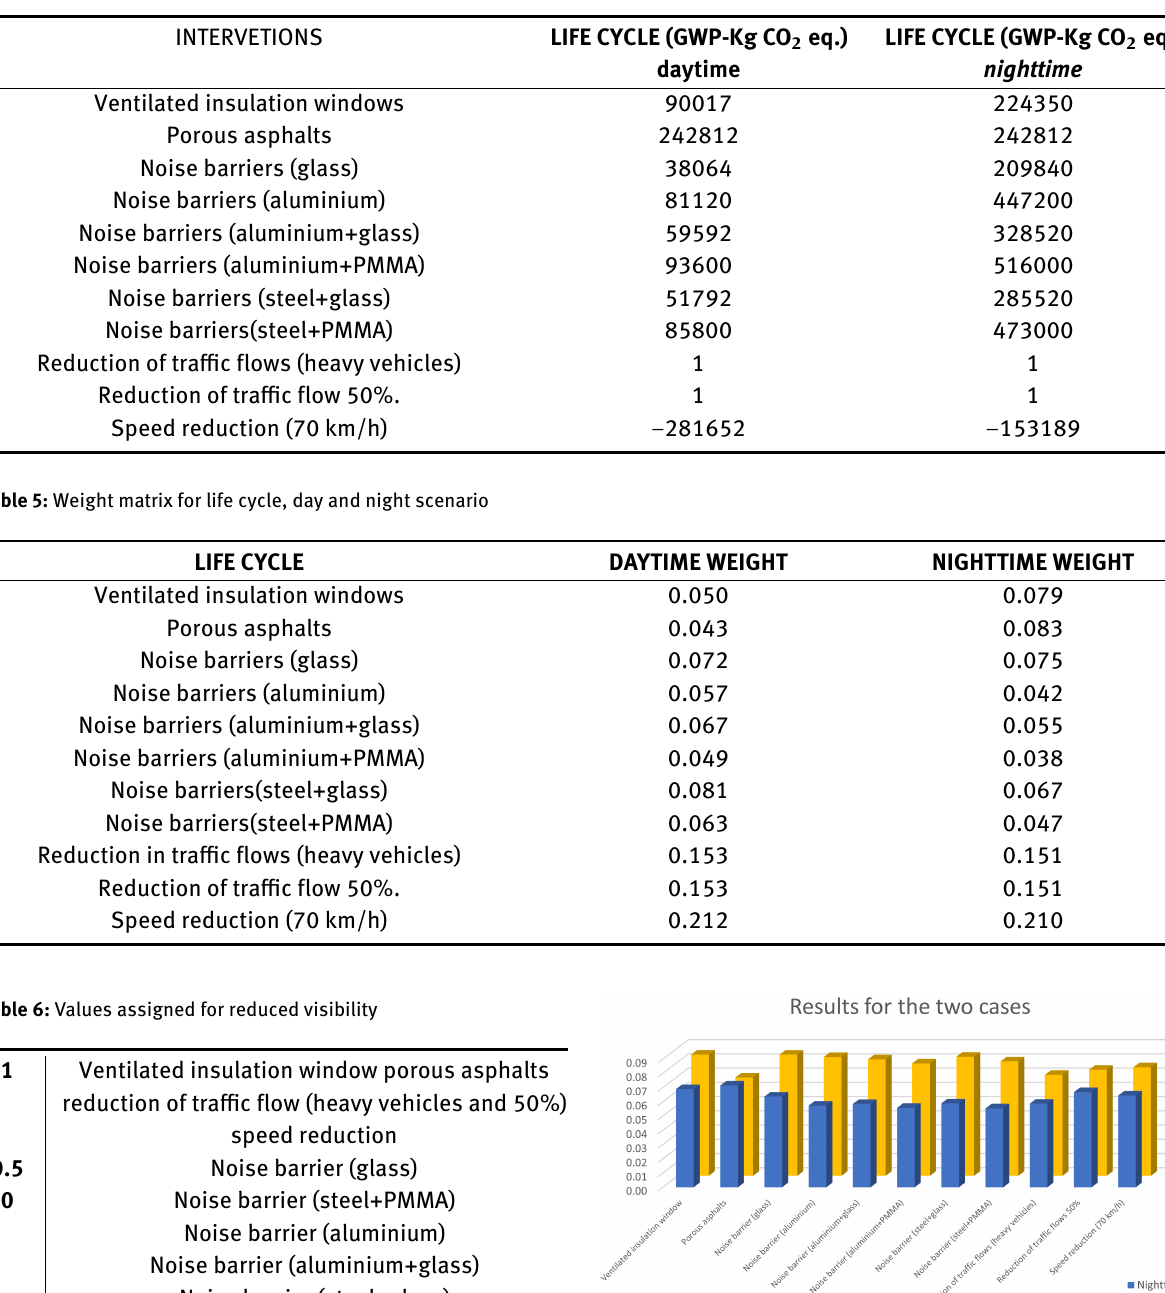
Table 4: GWP values for mitigation actions in the two scenarios